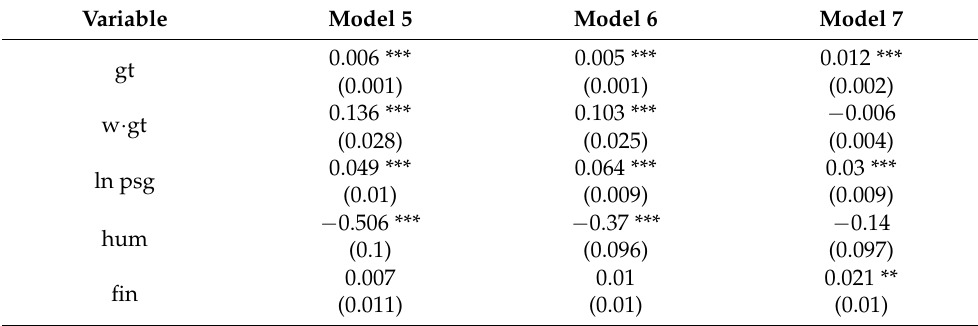
Table 5. Robustness test